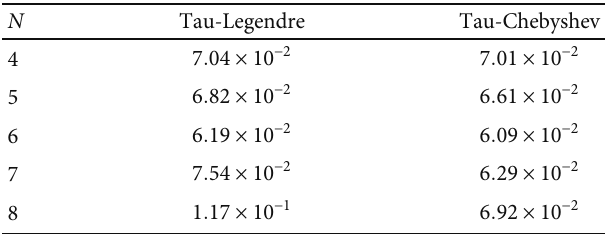
Table 2: L 2 w errors of the operational Tau methods with for Example